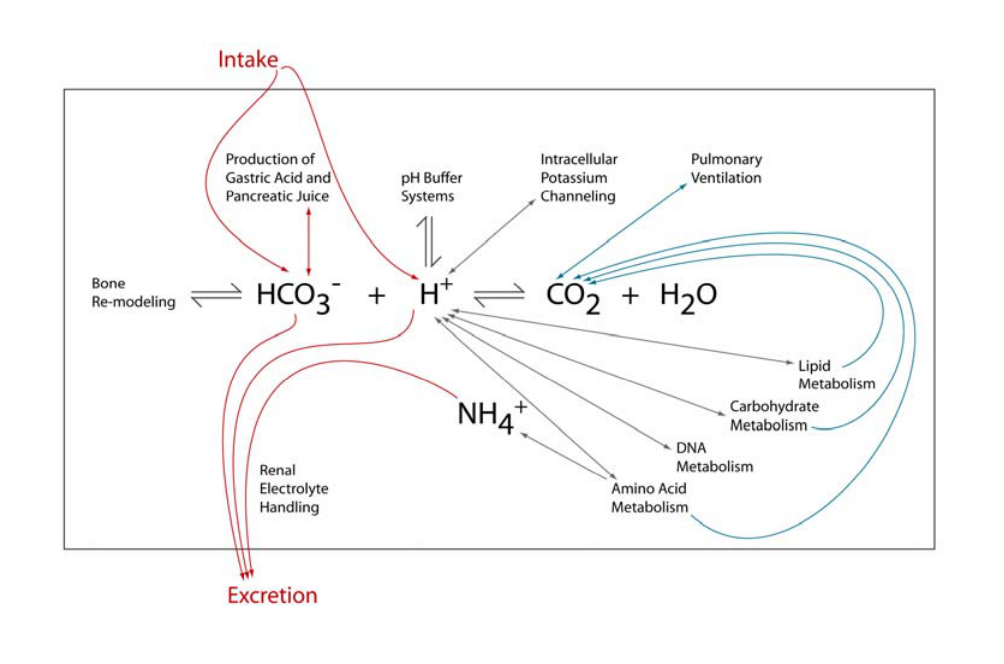
Figure 1: Synopsis of different factors contributing to acid-base balance. A considerable number of cellular functions are sensitive to alterations in pH, such that H + concentration is one of the most tightly controlled parameters in the body. Functions that are sensitive to pH include glycolysis, the pentose phosphate cycle, DNA synthesis, K + and Ca 2+ channel activity, gap junction conductance and haemoglobin oxygen affinity. Apart from the tight interplay of lungs - and HCO respectively, a substantial proportion of renal and kidneys in the elimination of CO 2 3 + , created through the breakdown of the amino acid acid elimination occurs in the form of NH 4 glutamine by the enzyme glutaminase. As the availability of glutamine in the blood also depends largely on glutamine metabolism in the liver, the differential regulation of glutaminase gene expression in the liver and kidneys to acidosis is a key mechanism in the body’s pH homeostasis. Adapted from